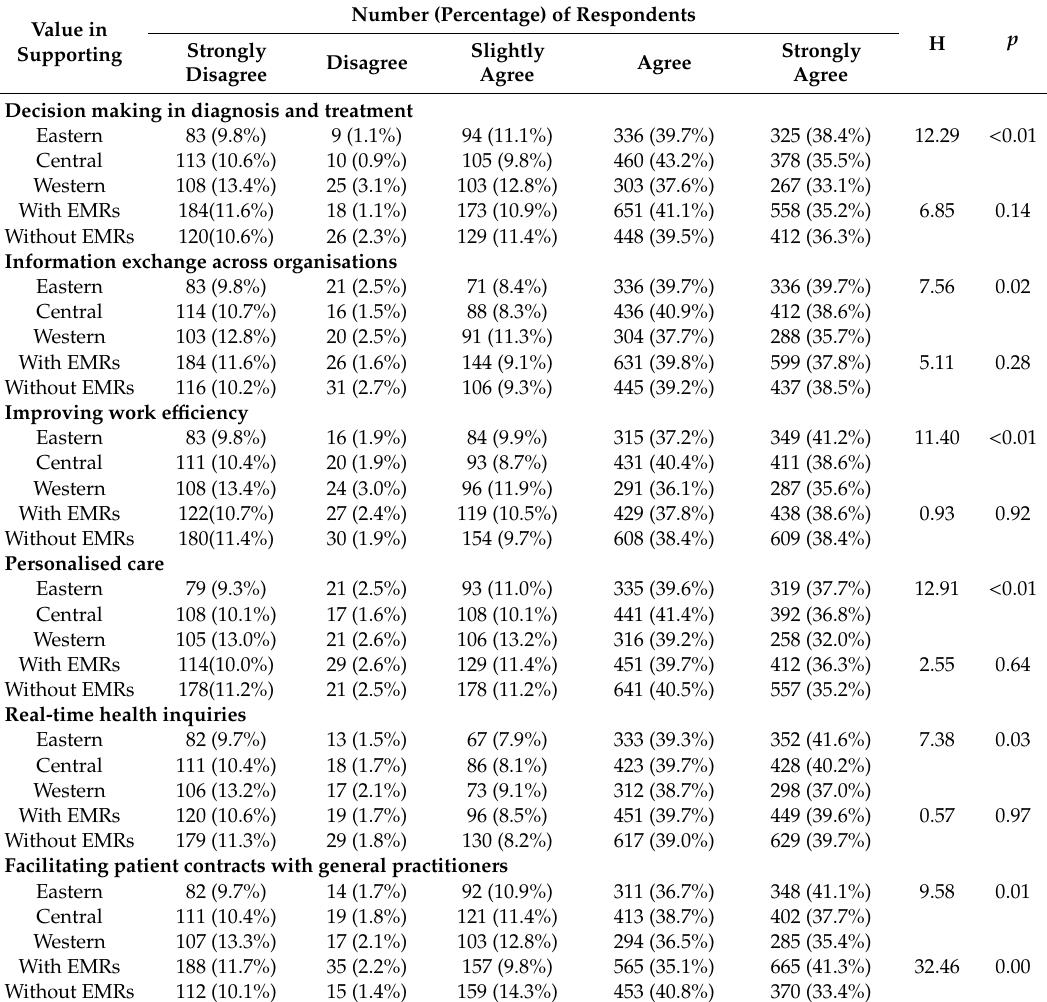
Table 3. Perceived value of electronic medical records in primary care ( n =